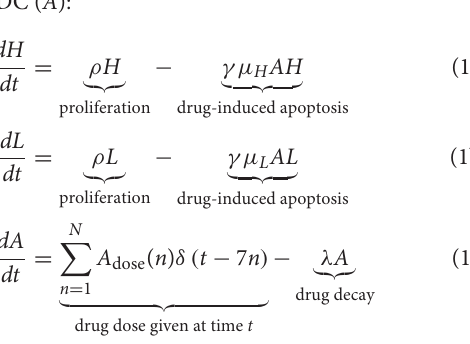
L ) and the ADC ( A ): TABLE 1 | Model parameter definitions and